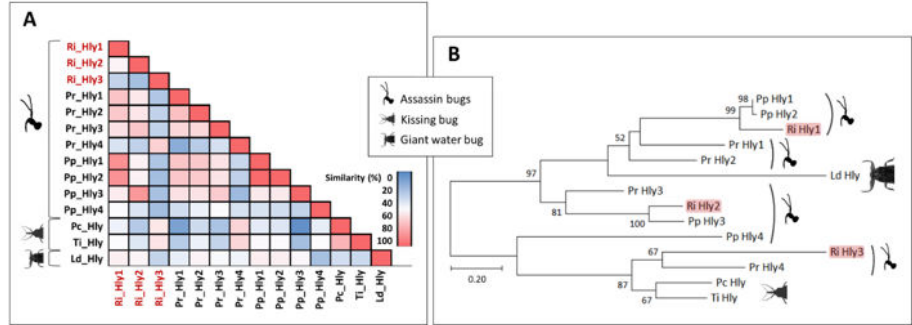
Figure 12. Characterization of hemolysins. ( A ) Pair-wise identity matrix of hemolysin sequences from insect order Hemiptera. Shown are hemolysins from the assassin bug R. iracundus (Ri_Hly), P. plagipennis (Pp_Hly), P. rhadamanthus (Pr_Hly), two kissing bugs T. infestans (Ti_Hly), and Panstrongylus chinai (Pc_Hly), and the giant water bug Lethocerus distinctifemur (Ld_Hly). ( B ) Phy- logenetic tree of hemolysins. Hemolysin sequences from three assassin bugs R. iracundus (Ri_Hly) (highlighted in red), P. plagipennis (Pp_Hly), and P. rhadamanthus (Pr_Hly), two kissing bugs T. infes- tans (Ti_Hly), and Panstrongylus chinai (Pc_Hly), the giant water bug Lethocerus distinctifemur (Ld_Hly) were analyzed together. The phylogenetic tree was inferred by using the Maximum Likelihood method and Whelan and Goldman model (Whelan and Goldman, 2001). The tree with the highest log likelihood ( − 2664.67) is shown.